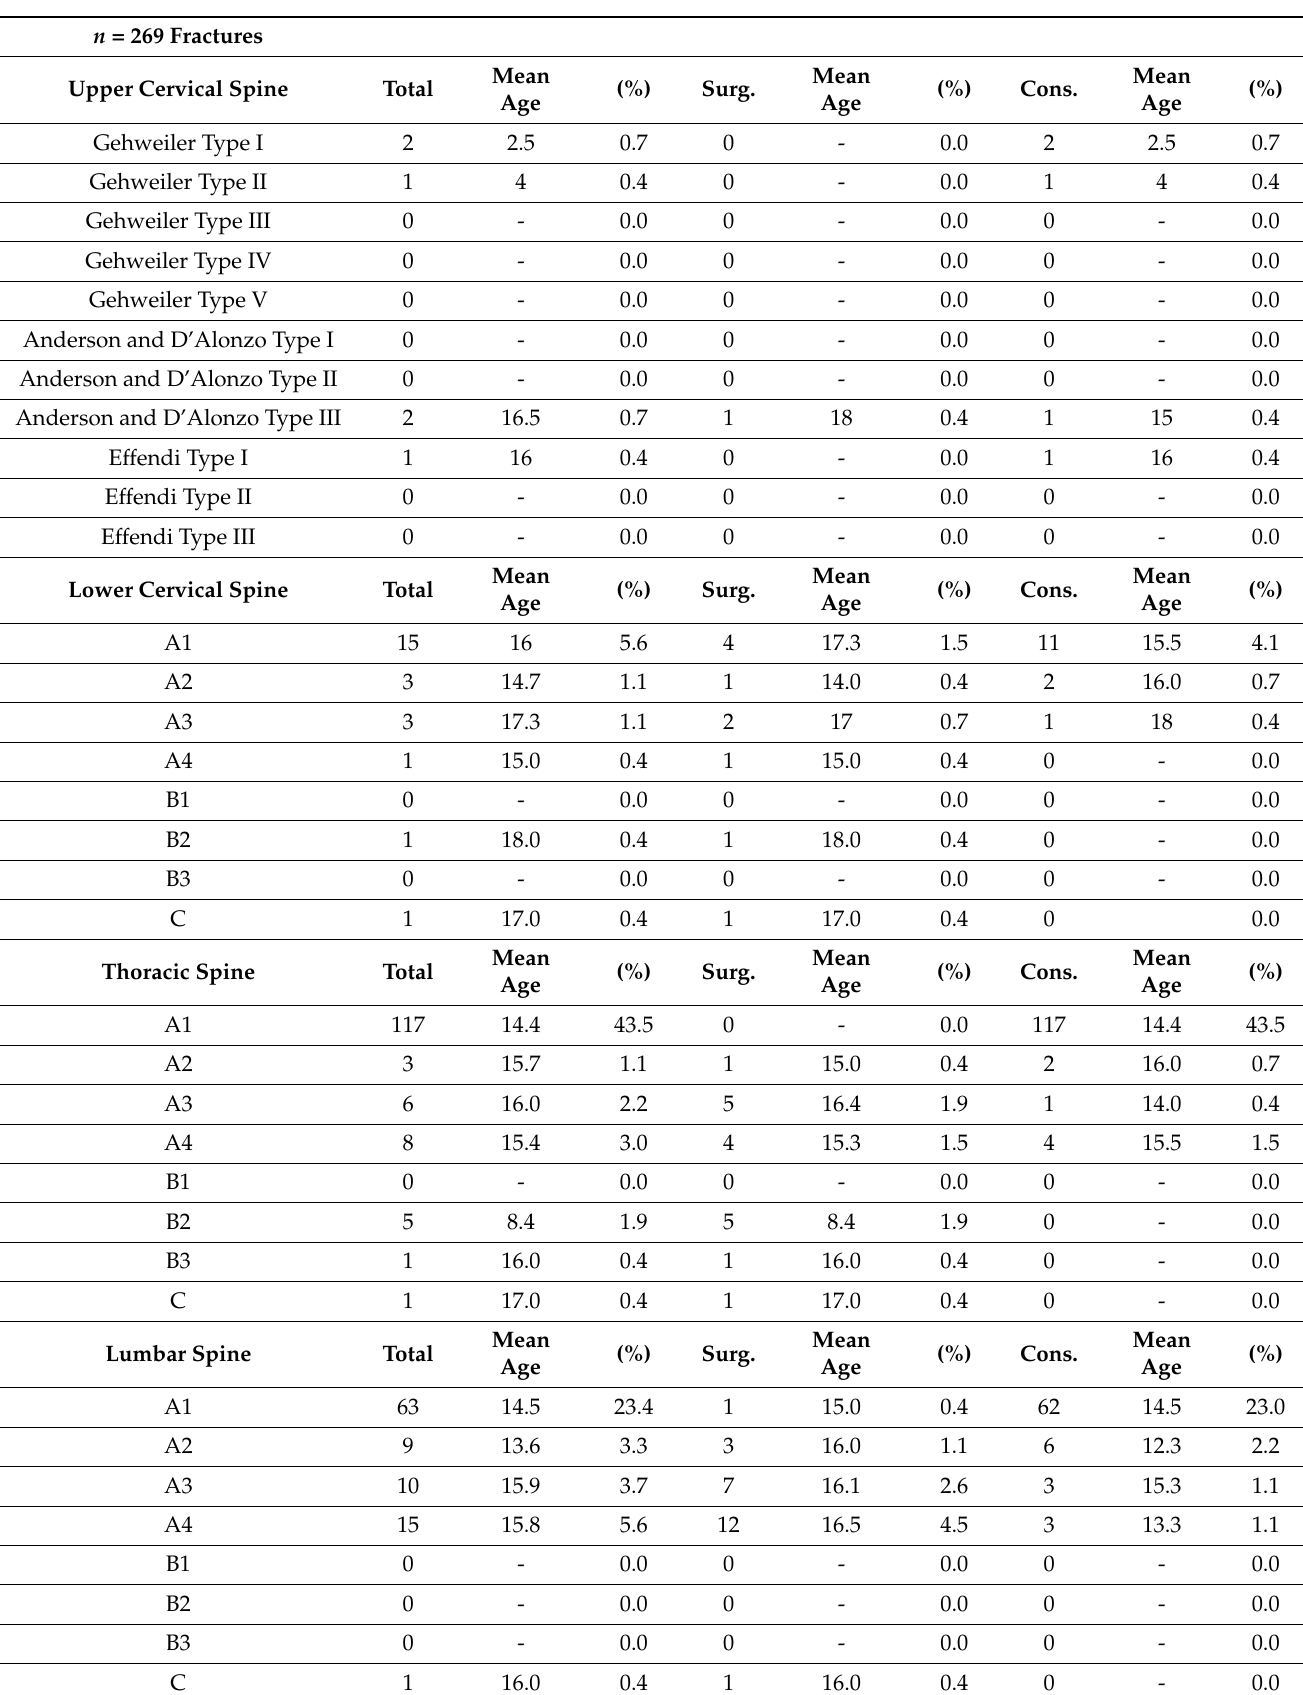
Table 4. AO Spine trauma classification system distributed between surgical (surg.) and conservative (cons.) treatment. n = 269 Fractures Upper Cervical Spine